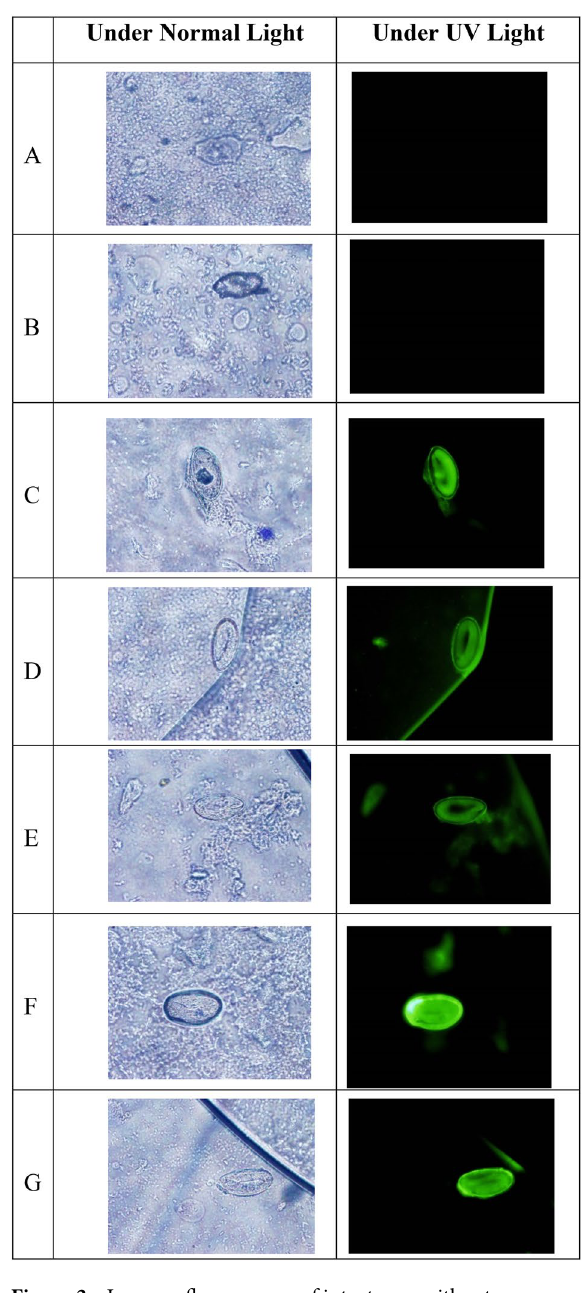
Figure 3. Immunofluorescence of intact eggs with rat serum on ( A ) Day 0, ( B ) Day 7, ( C ) Day 14, ( D ) Day 21, ( E ) Day28, ( F ) Day 35 and ( G ) positive human